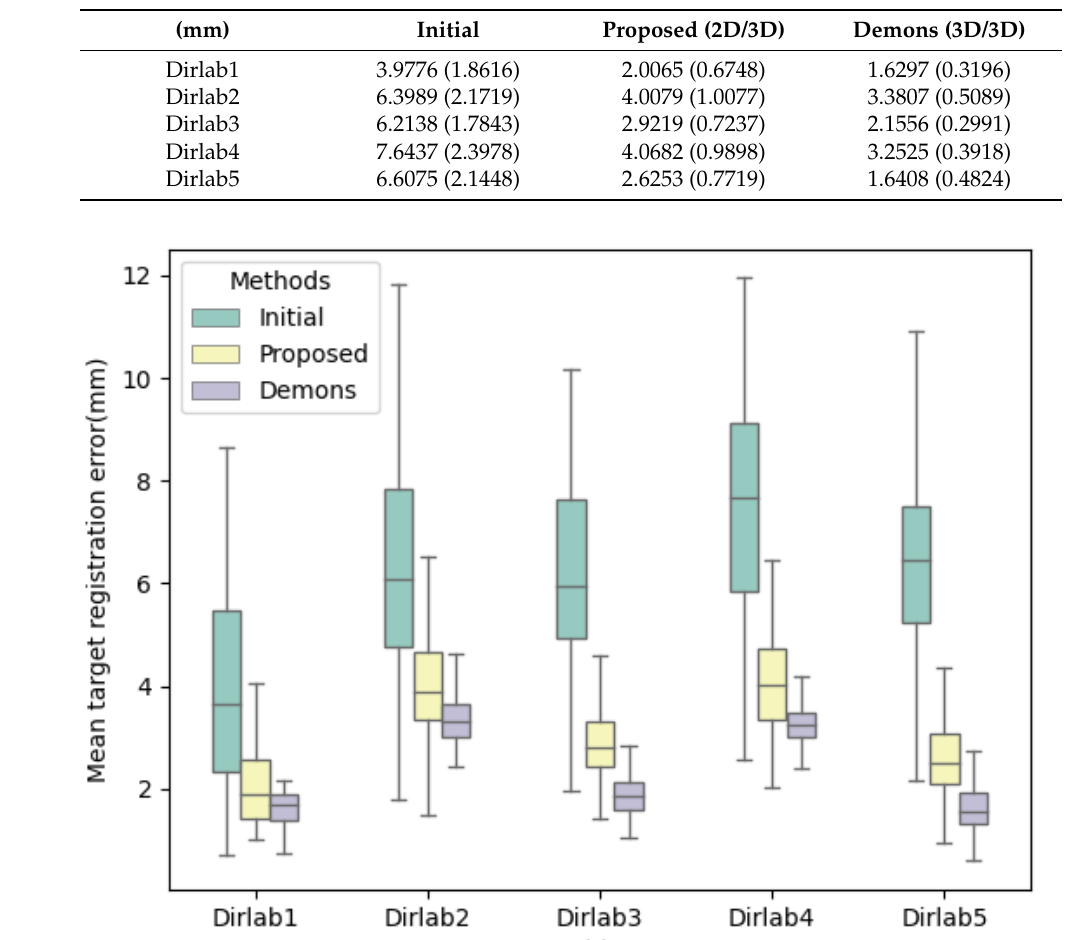
Table 3. Mean target registration error of landmarks in Dirlabs.